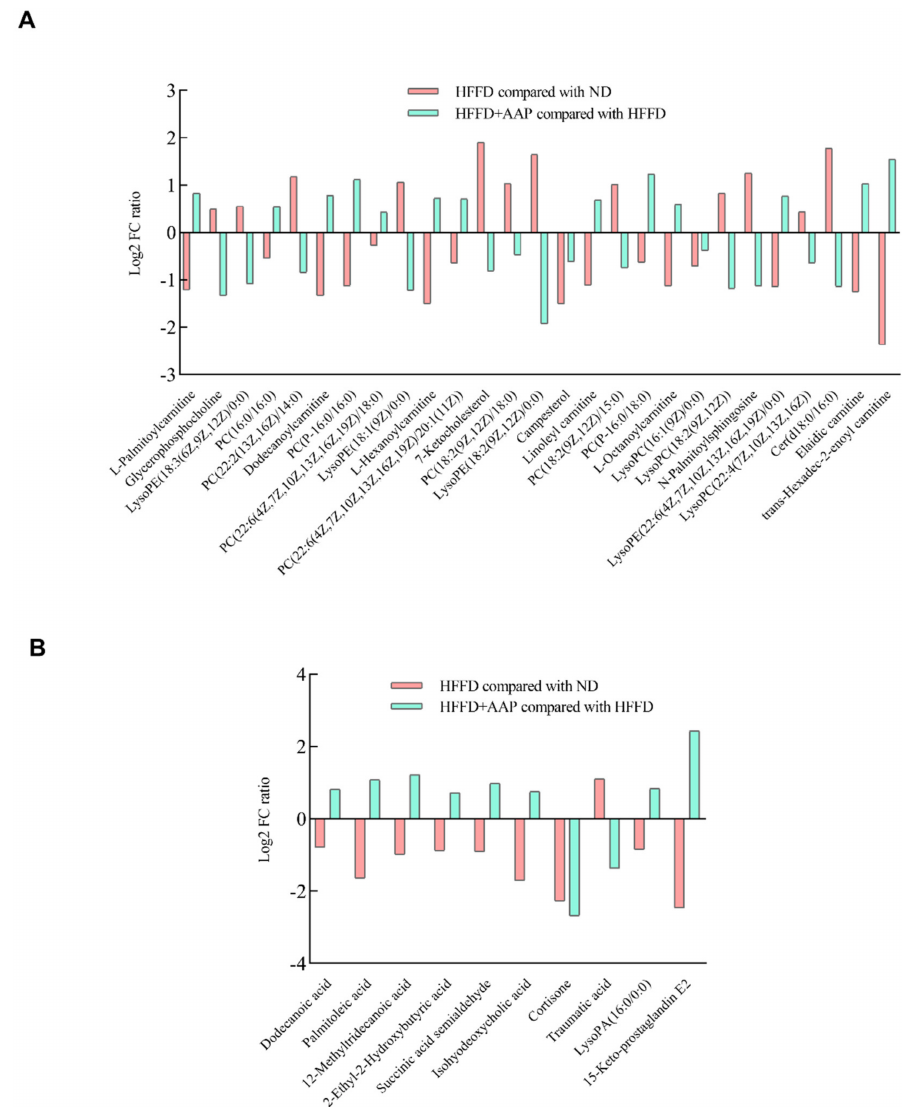
Figure 5. Effects of Auricularia auricula-judae polysaccharides on lipids and lipid-related metabolites in obese mouse serum. ( A ) Positive ion mode; ( B ) Negative ion mode. n =